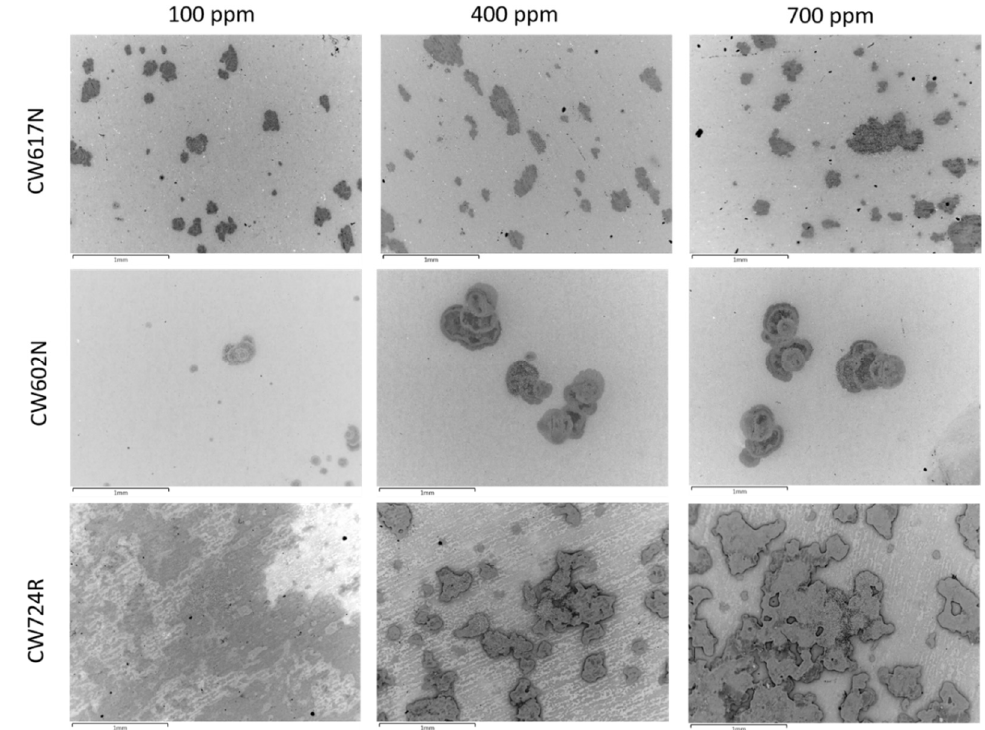
Figure 3. BS-SEM images of brass specimens after 24 h immersions in SDW solutions containing different chloride concentrations.